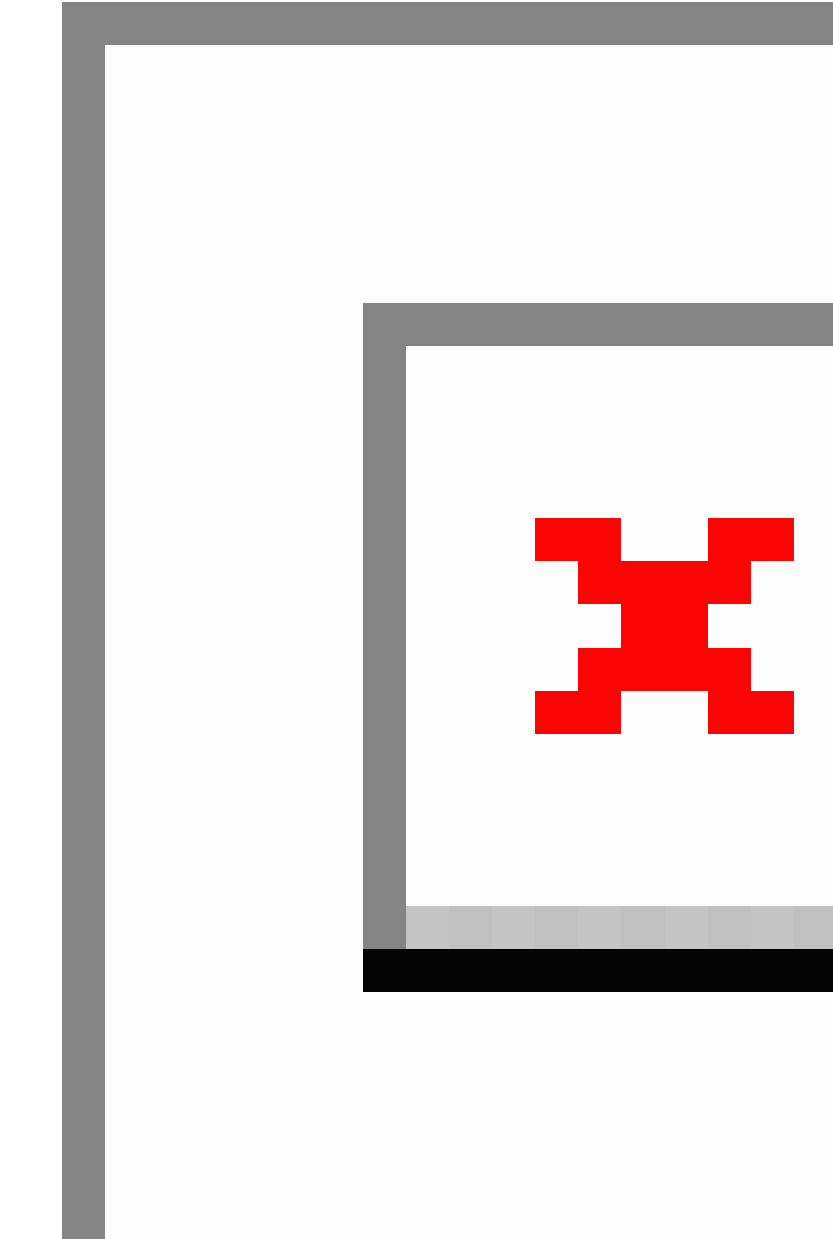
Figure 1. Distribution of age and gender (a, b) and computer, Internet, and e-mail usage (c to f). Spring semesters are indicated with 1 ; fall